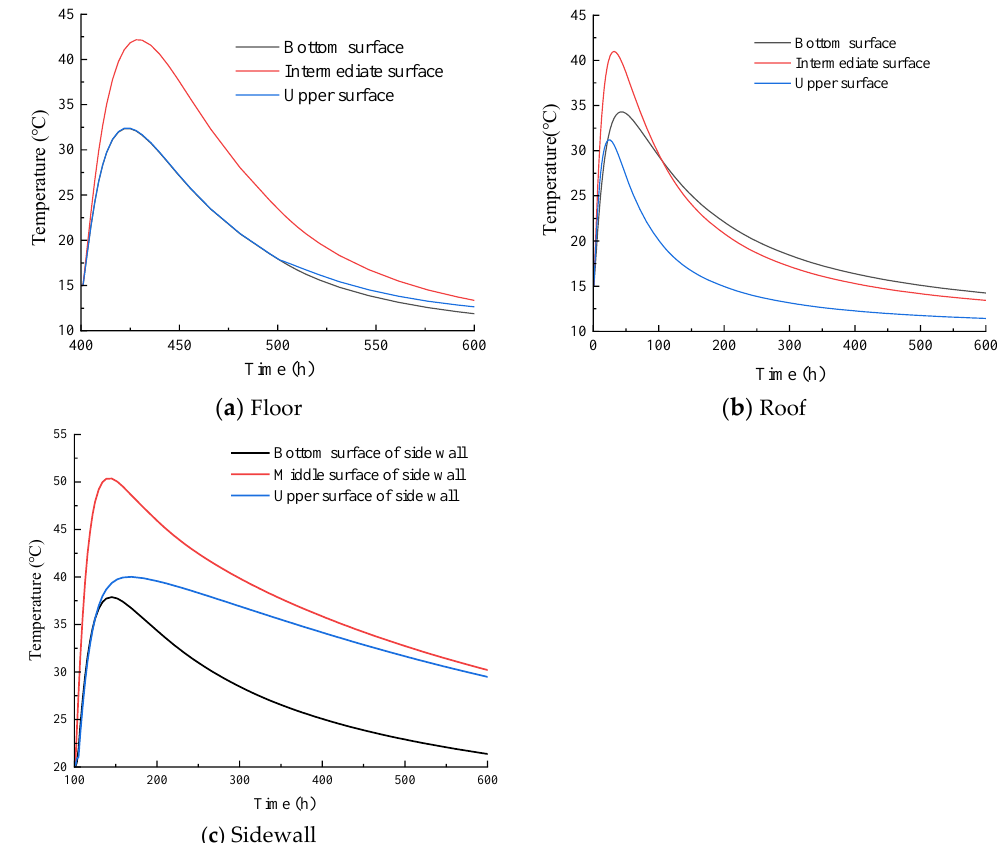
Figure 5. Temperature of concrete structure of metro station varies with time.